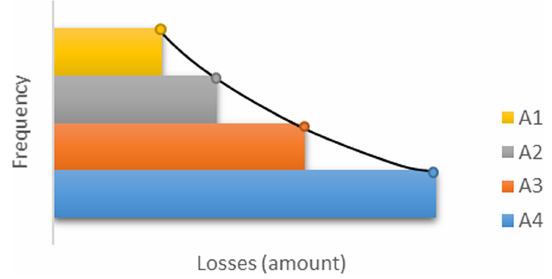
Figure 3. An example of risk curve in the form of staircase. A1– A4 represents the area derived from the loss calculation for four return periods. Each A1–A4 contributes to the risk total ( R) of the considered hazard event (e.g. debris